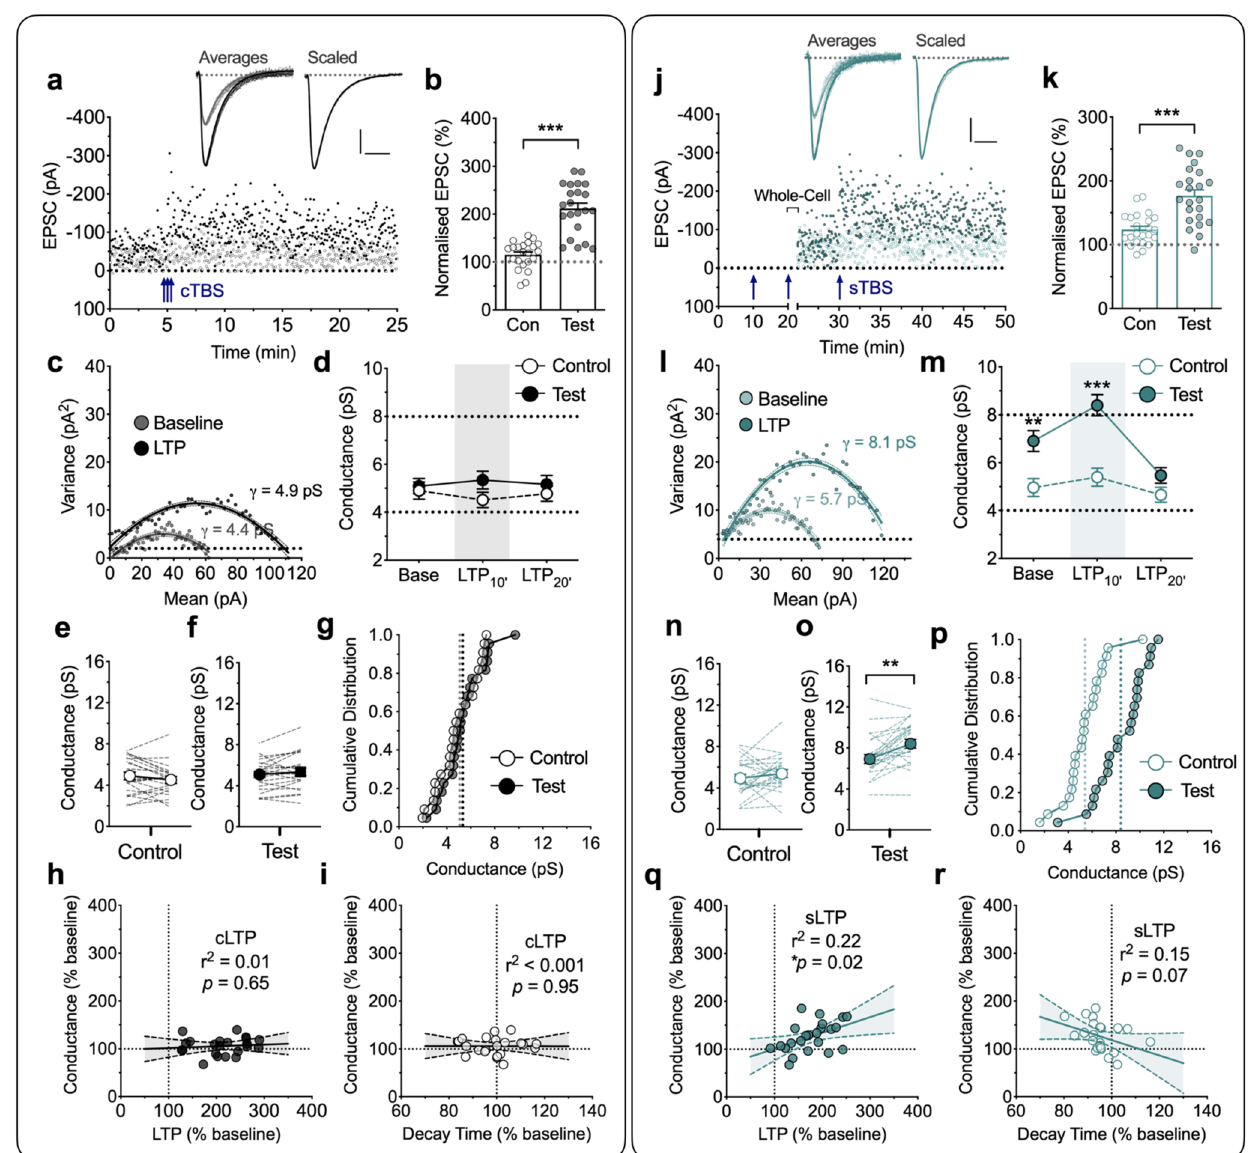
Fig. 2 Increased AMPA receptor unitary conductance ( γ ) during sLTP, but not cLTP. a A representative LTP experiment with sample traces for baseline and post TBS – the mean of selected records for analysis, superimposed with peak-scaled individual traces (10 successive sweeps, thin lines; baseline = grey, LTP = black). Scaled trace is from the baseline normalized to the LTP. Scale bars: 20pA and 10ms. Two inputs were stimulated alternately and cTBS (3x TBS with an inter-episode interval of 10s; blue arrows) delivered to one input ( fi lled symbols) with the second input (open symbols) serving as a control (Con). b Levels of cTBS-induced LTP (cLTP) for control and test inputs, quanti fi ed during the 10min epoch after the induction (mean ±SEM, n = 22 neurons from 15 animals; t 21 = 8.545, p < 0.0001, two-sided paired Student ’ s t test). c Corresponding current – variance relationship of the EPSCs for the test input. The unitary channel conductance ( γ ) of AMPA receptors was estimated during baseline (grey) and after the induction of LTP (LTP 10 ’ ; black). d Grouped comparison of control and test input γ estimates for baseline and the initial 10 min epoch (LTP 10 ’ ) and the subsequent 10min epoch (LTP 20 ’ ). n = 22 neurons from 15 animals. e , f Summary plot for the γ at baseline (left) and LTP 10 ’ (right) for control ( e ) and test ( f ) inputs. Individual values from each neuron are connected by lines. Circles indicate mean values. g Cumulative distribution of the same data set for LTP 10 ’ . Dotted lines indicate the mean values for each input. h , i Analysis of the relationships of γ with LTP ( p = 0.6517, F (1,20) = 0.2101, F -test) ( h ) and EPSC decay time ( p = 0.9521, F (1,20) = 0.0037, F -test) ( i ). Linear regression with 95% con fi dence intervals (shaded) for the amount of cLTP and the corresponding level of γ . j – r Equivalent analysis for the LTP induced by sTBS (3x TBS at inter-episode interval of 10min; see arrows). The whole-cell recordings were obtained after the second TBS. This was necessary due to the lability of LTP washout. k Levels of sTBS-induced LTP (sLTP) for control and test inputs, quanti fi ed during the 10min epoch after the induction ( n = 23 neurons from 17 animals; t 22 = 5.238, p < 0.0001, two-sided paired Student ’ s t test). m – o Statistical analysis between control and test pathways ( t 22 = 3.220, p = 0.0039 for baseline and t 22 = 6.123, p < 0.0001 for LTP 10 ’ , two-sided paired Student ’ s t test) ( m ) and within pathway analysis for control ( t 22 = 1.065, p = 0.2986, two-sided paired Student ’ s t test) ( n ) and test ( t 22 = 3.753, p = 0.0011, two-sided paired Student ’ s t test) ( o ) pathway reveals a time- and pathway-dependent increase in γ . Note that higher conductance was observed in the test input ( o ) compared to the control ( n ) under the “ baseline ” state, suggesting that the fi rst + second TBS were suf fi cient to increase γ . The third TBS triggered a small but discernible further increase in γ . q , r Analysis of the relationships of γ with LTP ( p = 0.0225, F (1, 21) = 6.066, F -test) ( q ) and decay time of EPSCs ( p = 0.0712, F (1,21) = 3.612, F -test) ( r ). Data are presented as mean± SEM. Source data are provided as a Source Data fi